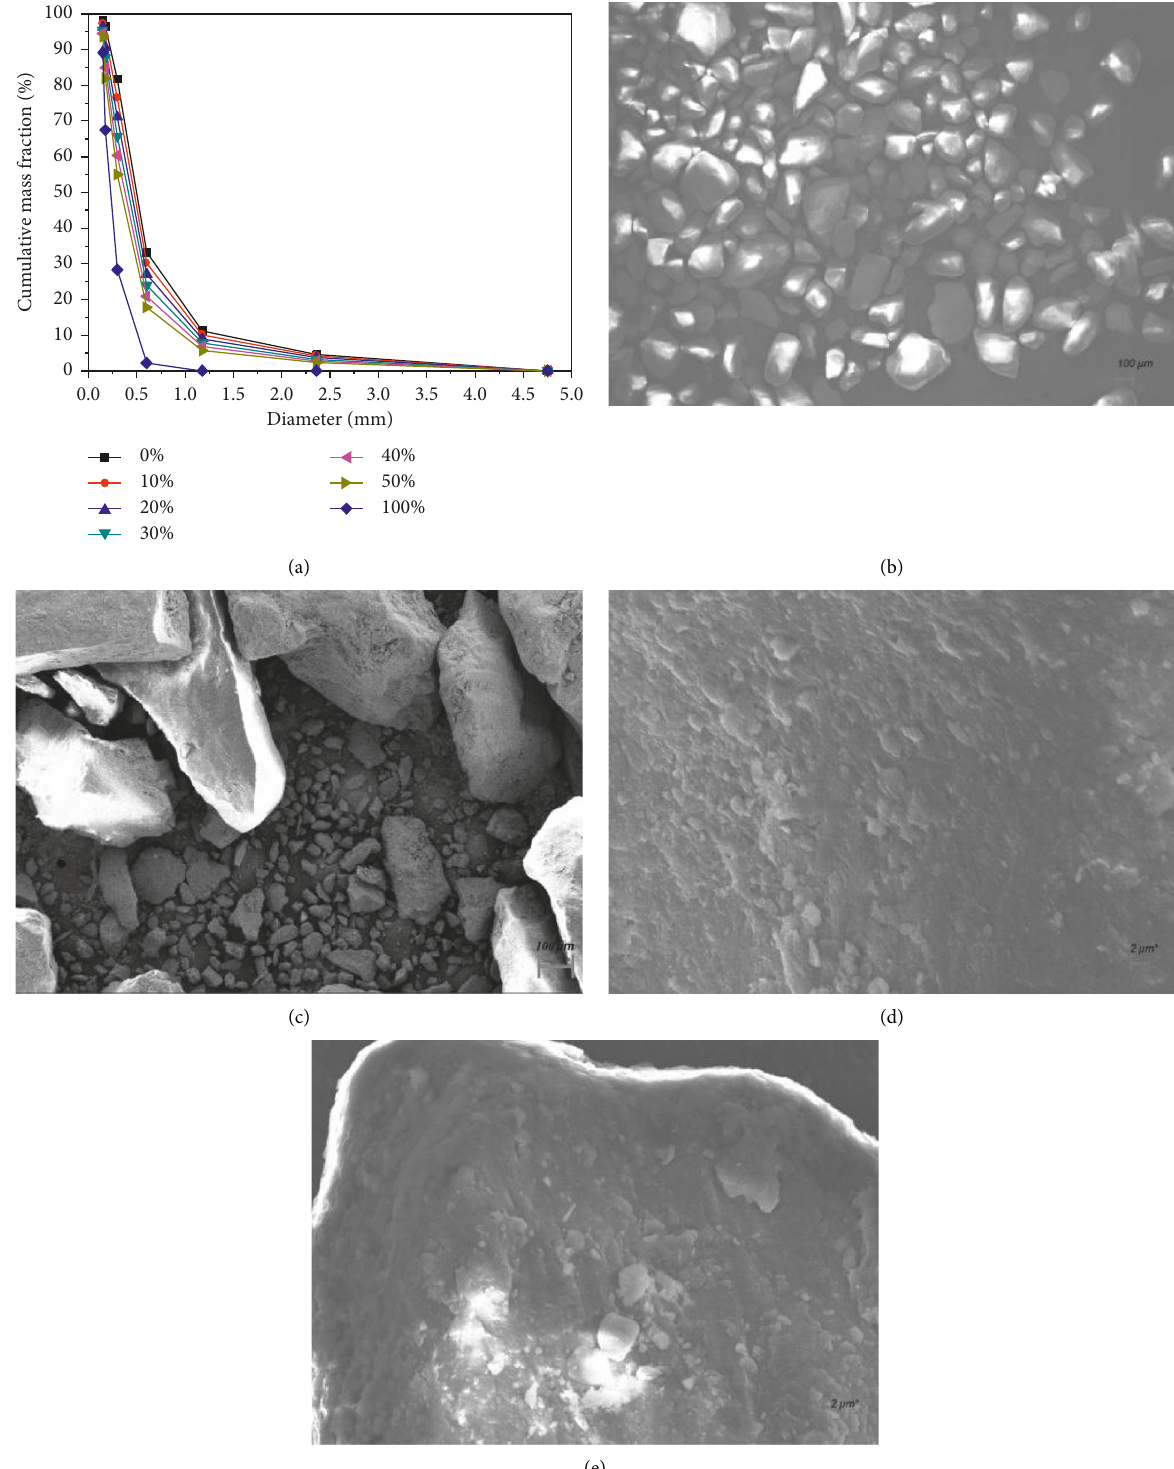
Figure 1: Physical characteristics of the used sand. (a) Particle size distributions of each sample. (b) Aeolian sand SEM image (100 μ m). (c) River sand SEM image (100 μ m). (d) Microscopic appearance of river sand (2 μ m). (e) Microscopic appearance of aeolian sand (2 μ